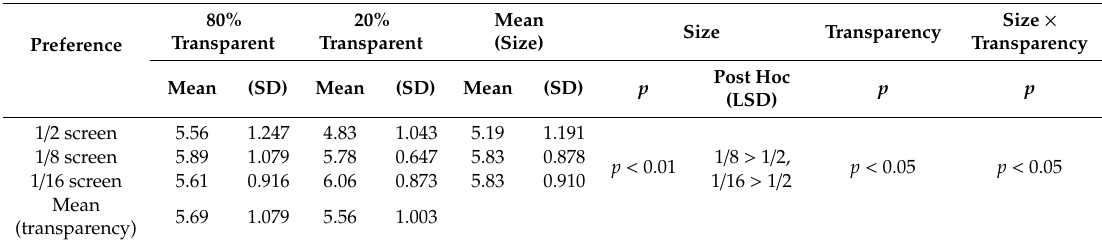
Table 7. Descriptive statistics and two-way ANOVA of